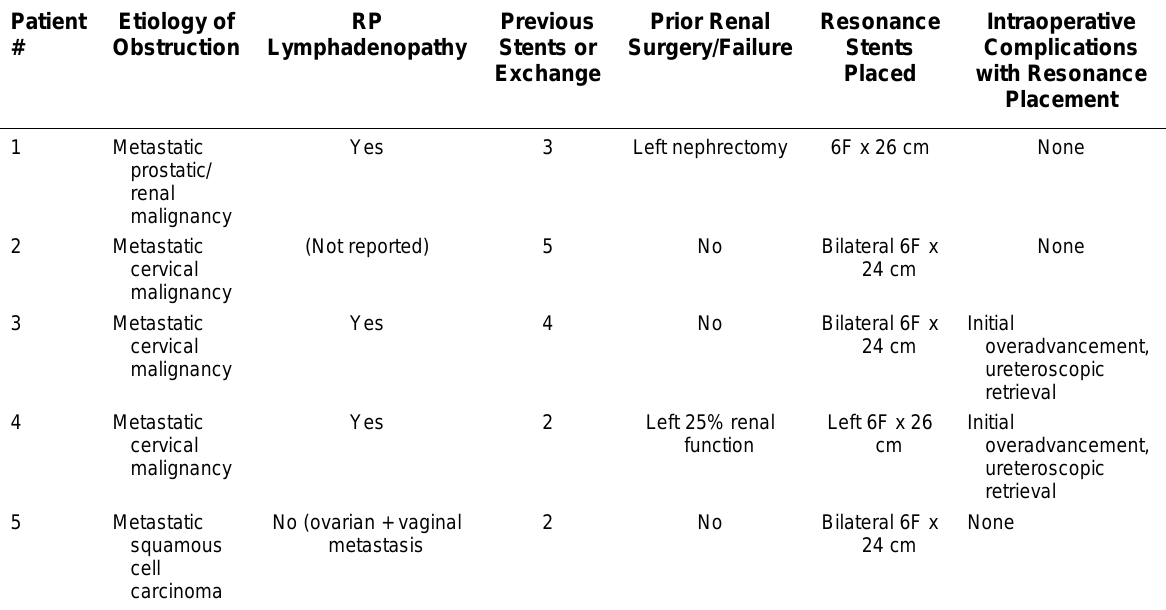
Preoperative Patient